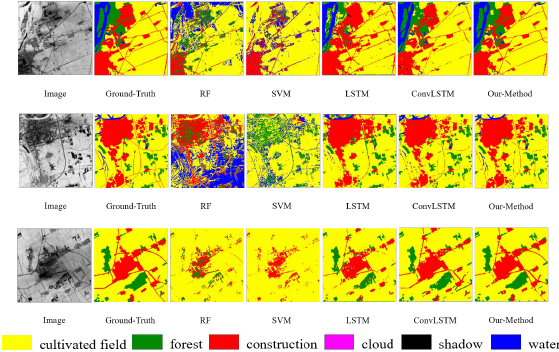
Figure 8. The testing results of different models are displayed. From top to bottom is Data_1, Data_2 and Data_3.